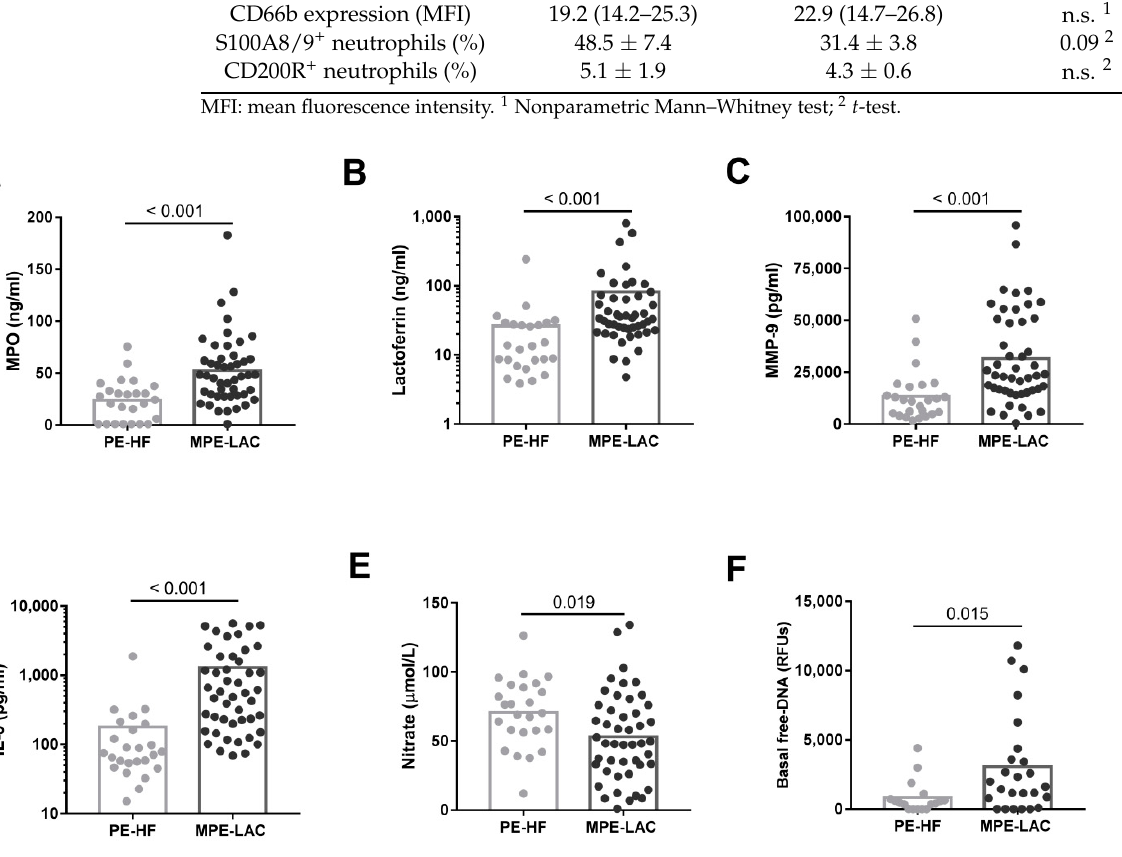
Figure 1. Pleural fluid concentrations of soluble neutrophil-related molecules. Levels of ( A ) myeloper- oxidase (MPO; ng/mL), ( B ) lactoferrin (ng/mL), ( C ) matrix metalloproteinase-9 (MMP-9; pg/mL), ( D ) IL-8 (pg/mL), and ( F ) nitrate ( µ mol/L) in pleural effusions from heart failure (PE-HF) ( n = 25) and lung adenocarcinoma (MPE-LAC) ( n = 47) cell-free pleural fluids determined by the corresponding ELISAs. ( F ) Pleural extracellular DNA was measured in PE-HF ( n = 17) and MPE-LAC ( n = 25) by fluorescence intensity and expressed as relative fluorescence units (RFUs). The unpaired T -test ( E ) and the Mann–Whitney test ( A – D ), ( F ) were used for statistical analyses. P -values are shown in the